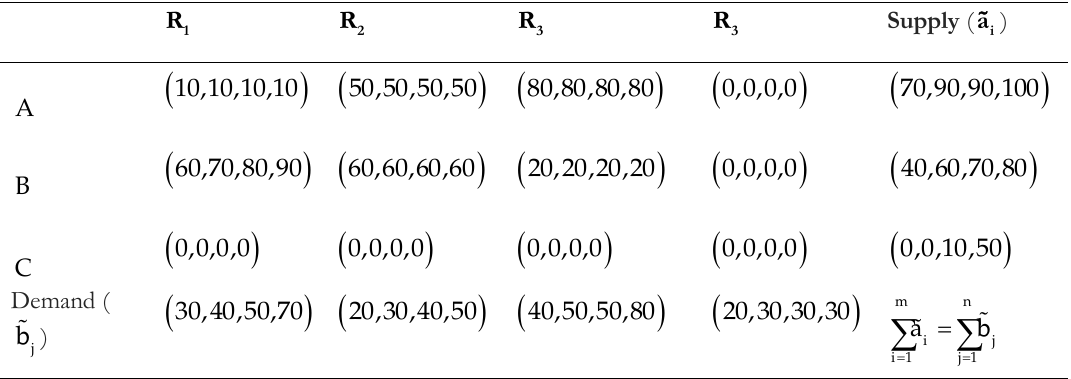
Table 1. Eq. (15) in trapezoidal unbalanced